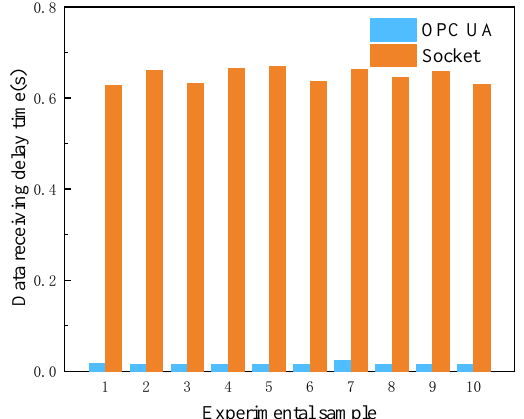
Figure 8. Communication time delay comparison.